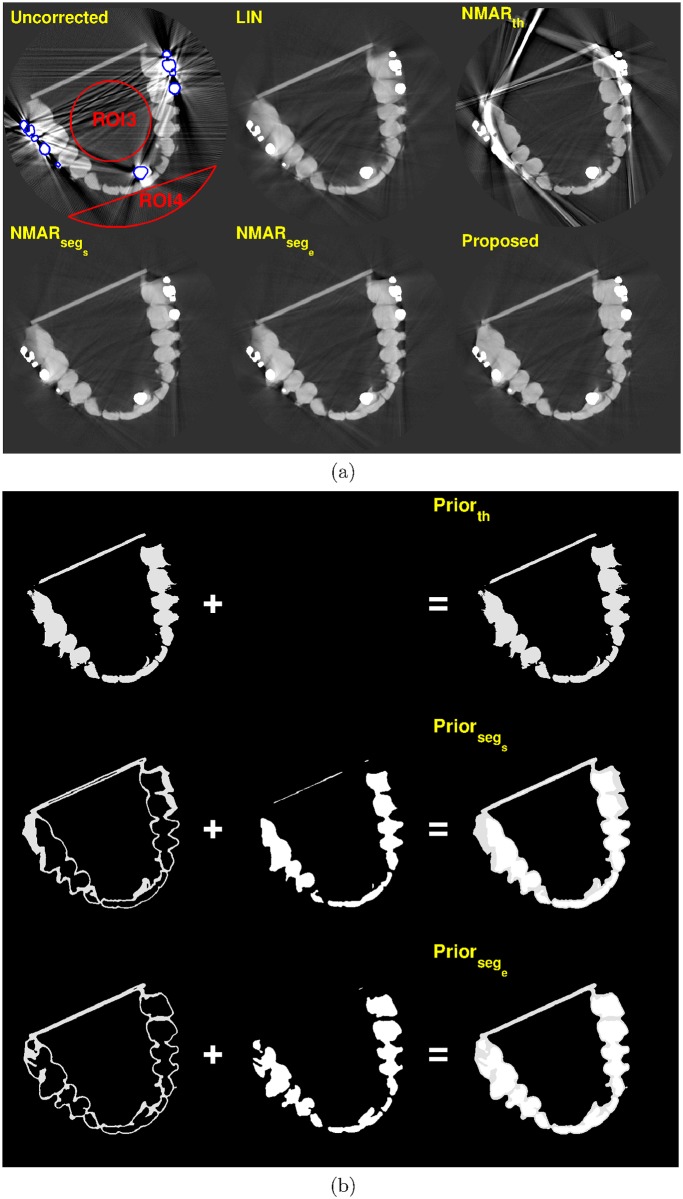
Results of tooth phantom with orthodontic bracket, on slice # 114 (C = -250 HU/W = 1250 HU).(a) Top row: reconstruction images by (left) Uncorrected, (middle) LIN, and (right) NMARth images. Bottom row: reconstruction images by (left) NMARsegs, (middle) NMARsege, and (right) the proposed results. ROI 3 and ROI 4 are indicated by red lines on the uncorrected image. (b) Prior images by (top) simple thresholding, (middle) RAC segmentation of LIN image, and (bottom) RAC segmentation of final iteration image.